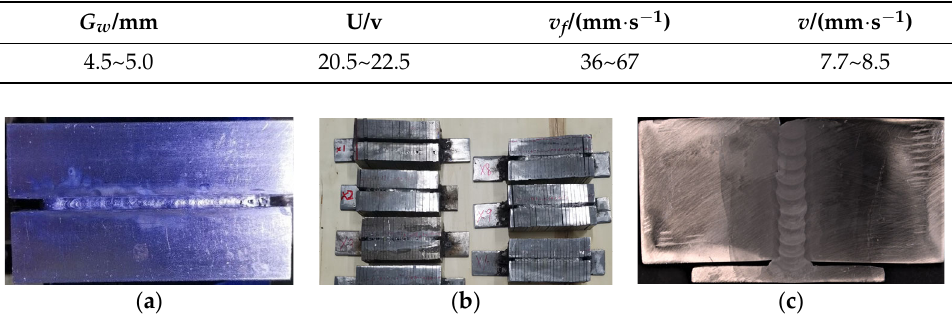
Figure 2. Description of the process of obtaining weld cross ‐ section slices: ( a ) welding specimen; ( b ) specimens after slicing; ( c ) specimens after slicing and etching.